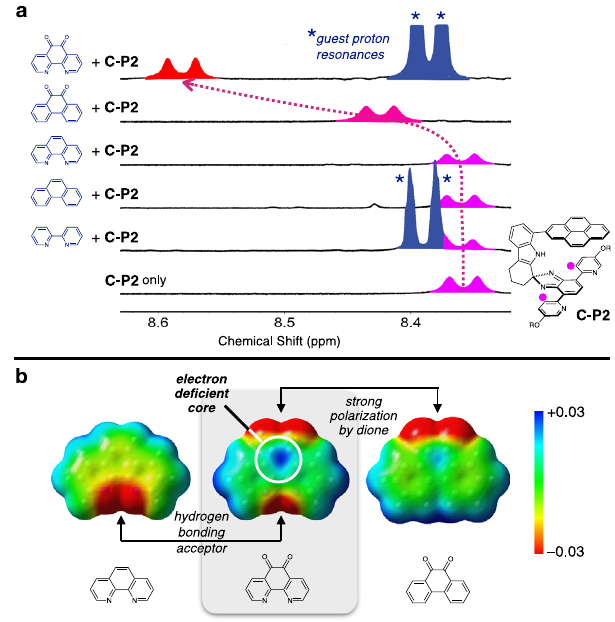
Fig. 9 Selective intercalation of π -conjugated guest. a Partial 1 H NMR spectra (400 MHz) of C-P2 obtained in the presence of various poly(hetero)aromatic guests G in CDCl 3 at T = 298 K ([ C-P2 ] = 4.0 mM; [G] = 16.0 mM). The pyridyl proton (denoted with purple circles in the chemical structure of C-P2 ) resonances are shaded with purple to red.